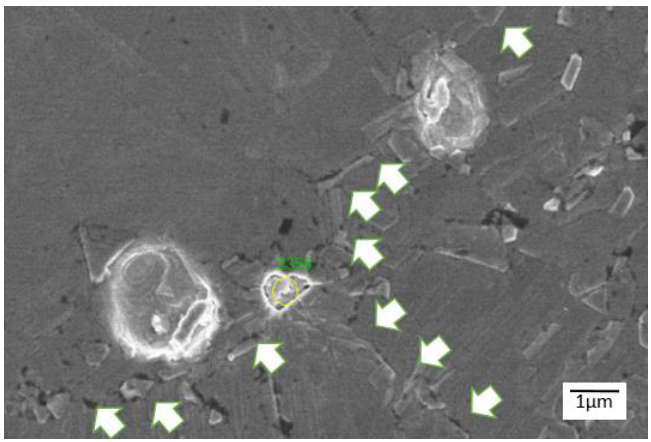
Figure 6. Interaction between grain boundaries and inclusions obtained by SEM.